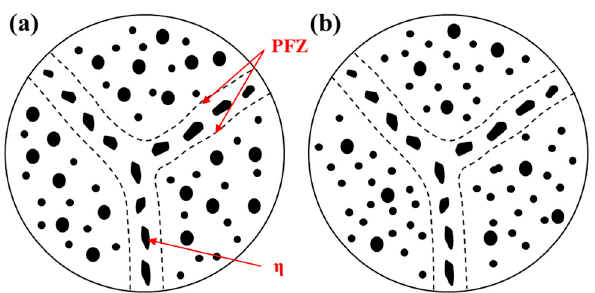
Figure 17. Precipitate distribution near the grain boundary of two-stage over aging ( a ) T74; ( b ) high-temperature followed by low-temperature aging [126–128].